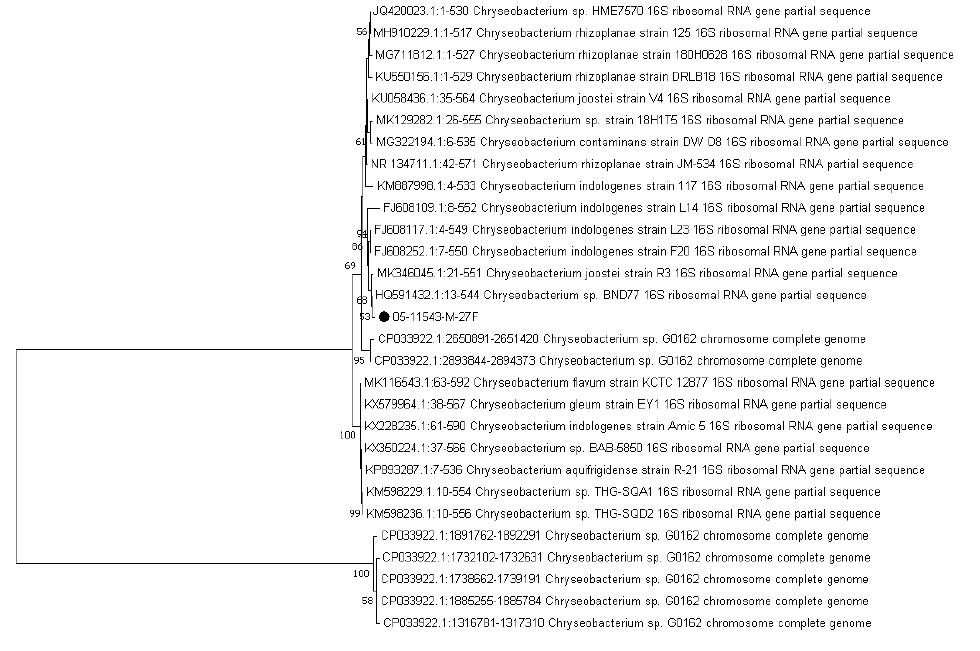
Figure 2. Phylogenetic tree based on 16s rRNA sequencing and neighbor-joining method classification among the strain isolated in this report (NCBI, GenBank accession number: MT276587) and the strains isolated from humans reported by other researchers published in NCBI.